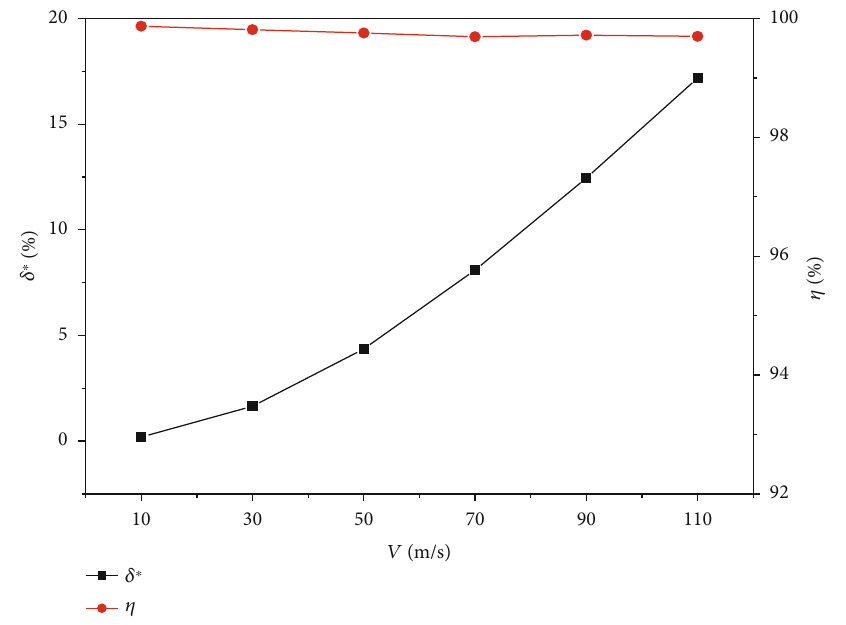
Figure 25: Total pressure loss and combustion e ffi ciency under di ff erent inlet velocities.